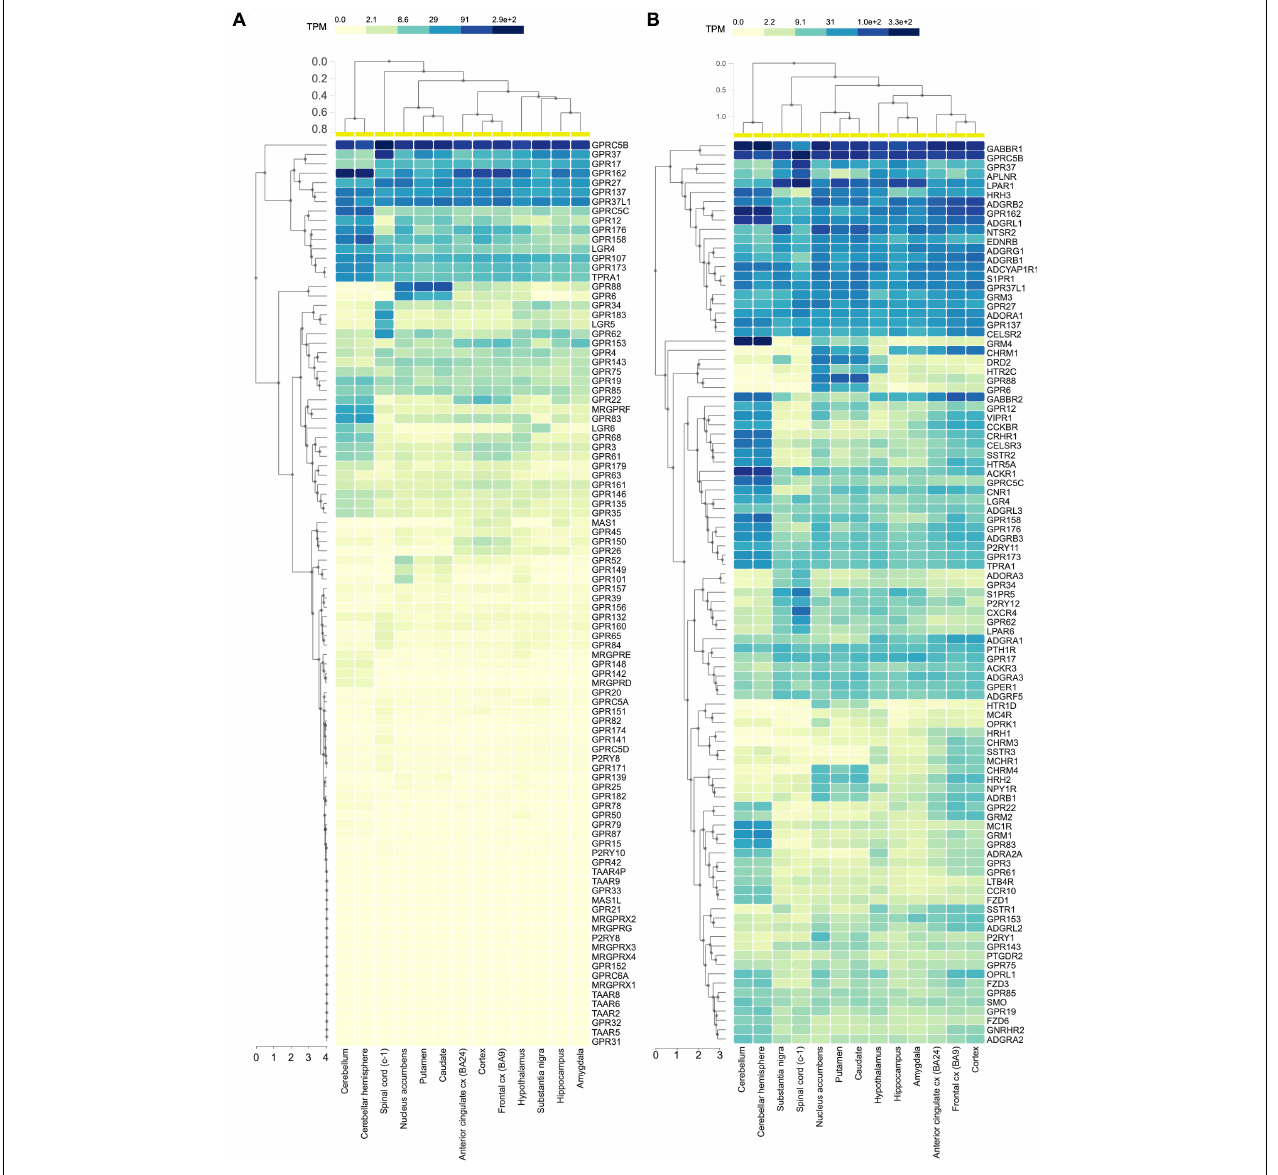
FIGURE 1 | GPRC5B is the most expressed oGPCR in the CNS. (A) Human RNA sequencing data analyzing 96 orphan GPCRs from the GTEx portal show high expression levels of GPRC5B. (B) GTEx portal RNA sequencing data reporting expression levels across brain regions of the 100 most expressed GPCRs in the